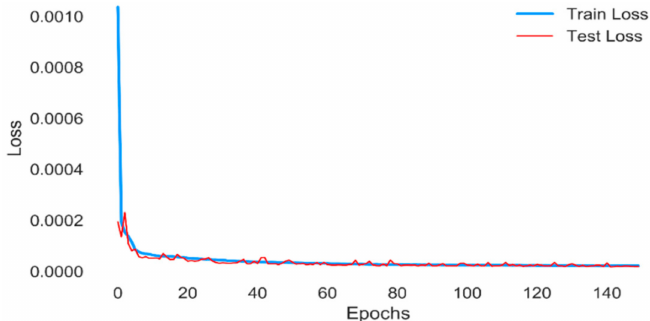
Figure 12. Decay of loss function for the training and testing sets for the multi-sequence